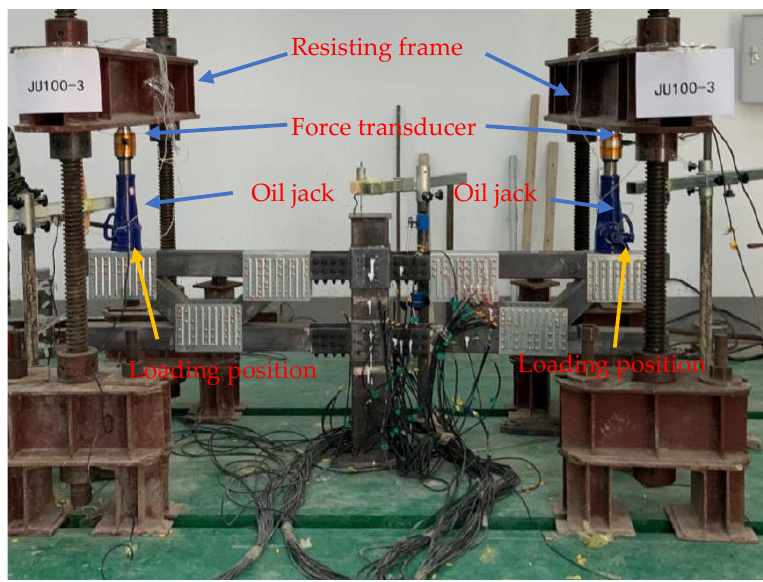
Figure 11. Testing rig.